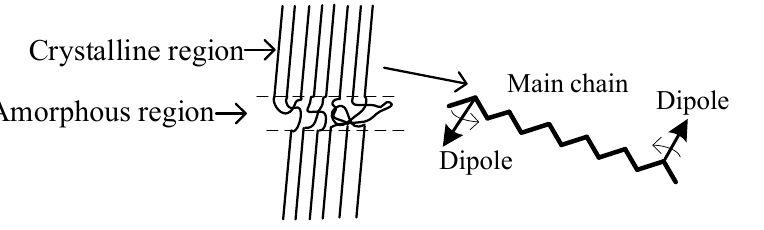
Figure 13. The arrangement of XLPE molecular structure and its main chain.